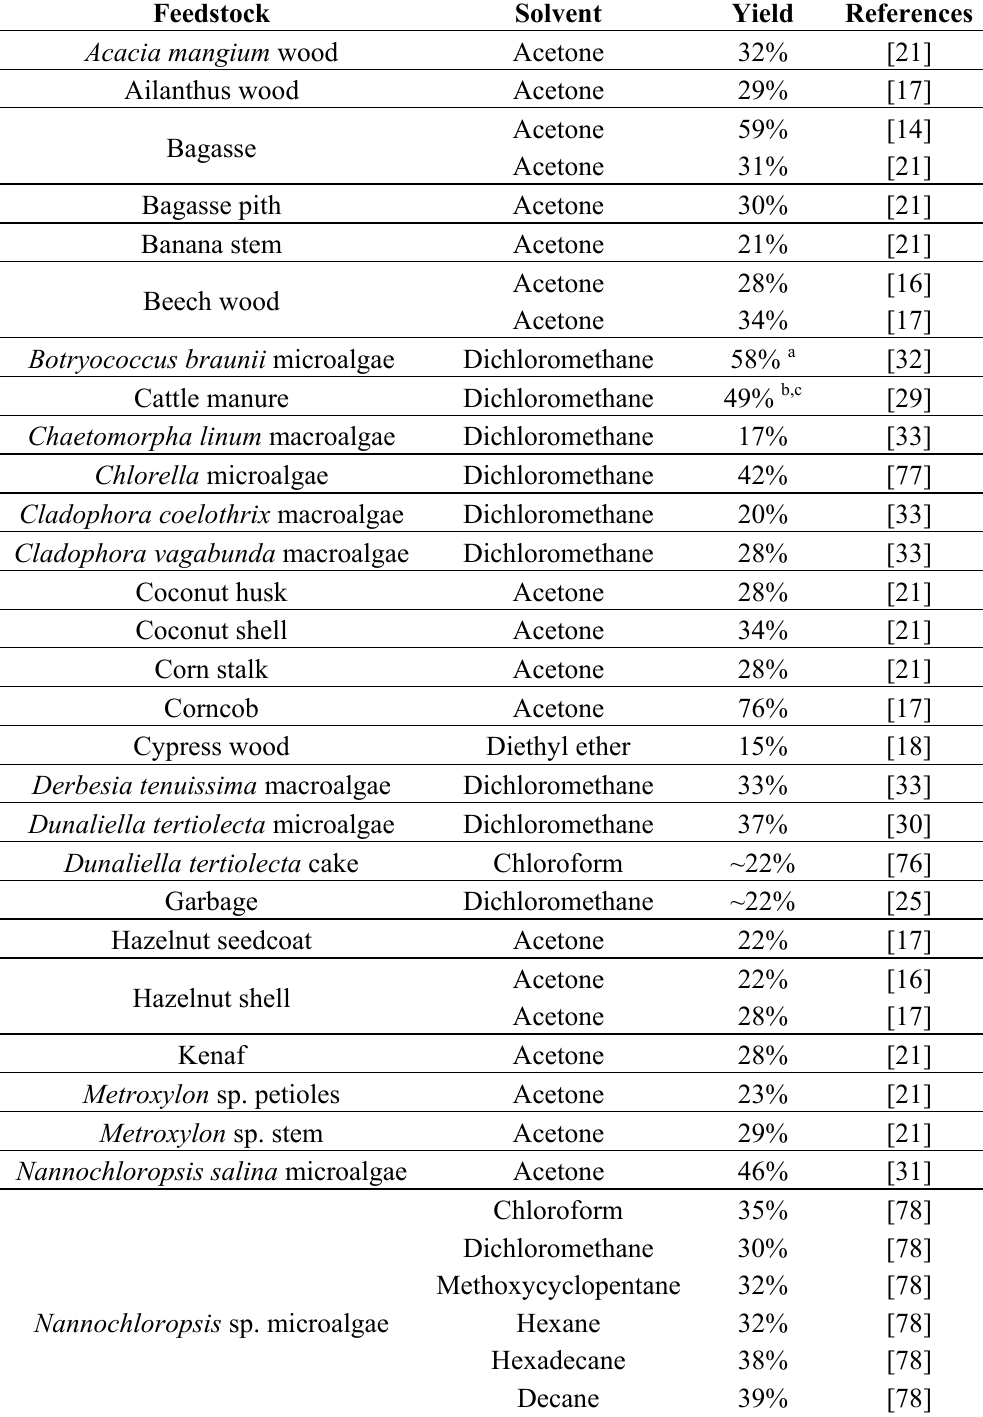
Table 4. Yields of solvent extraction of HTL bio-crude from the liquid fraction using polar and non-polar